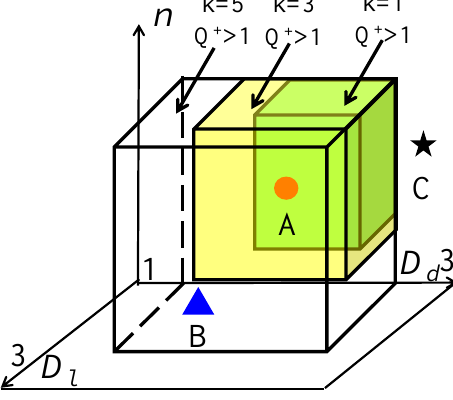
Figure 7. Schematic of imbibition parameter cube.